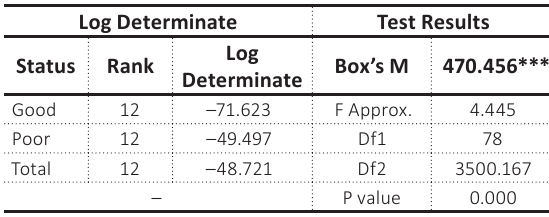
Table 4. Covariance matrices equality